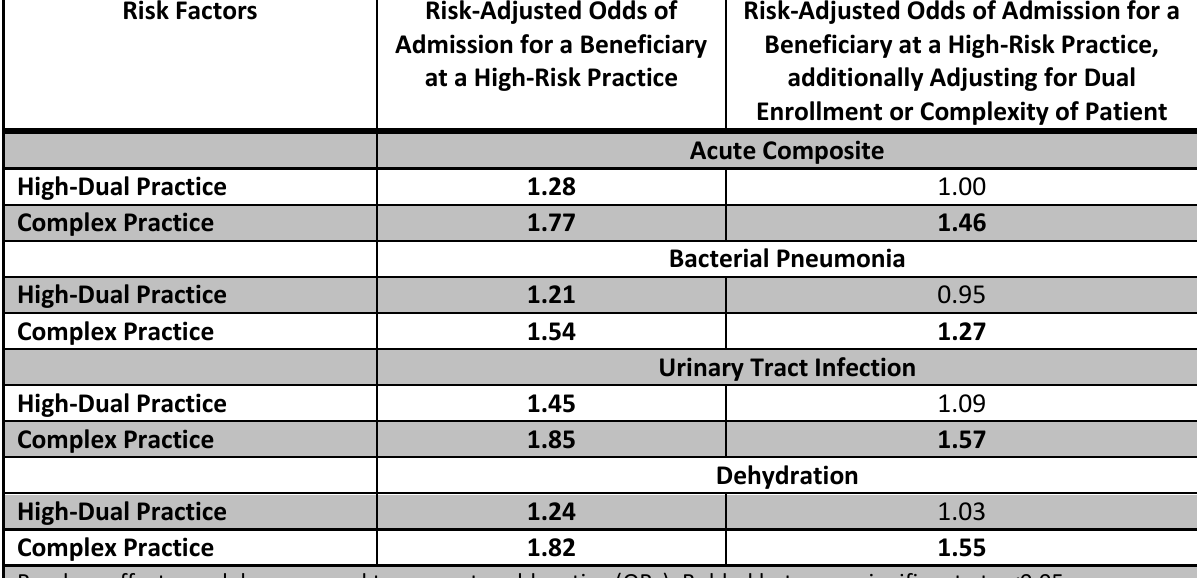
Table 10.9. Practice Factors in